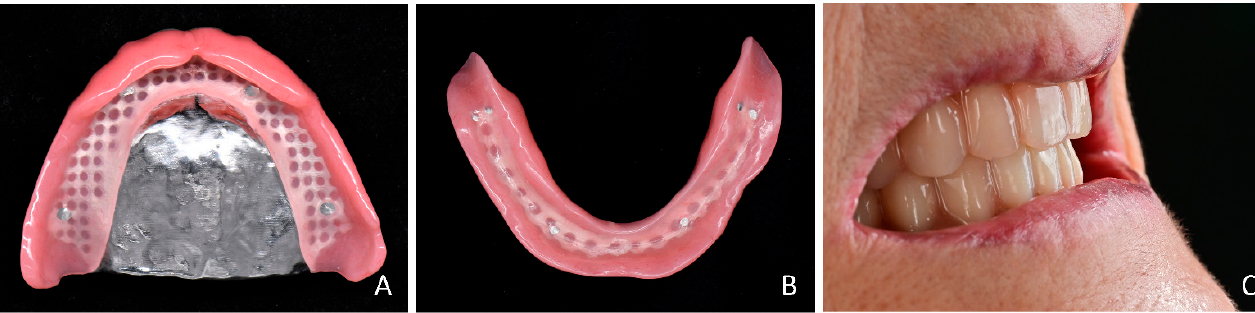
Figure 6. Final prosthesis after polishing. ( A ) Maxillary denture. ( B ) Mandibular denture. ( C ) Intraoral photograph.